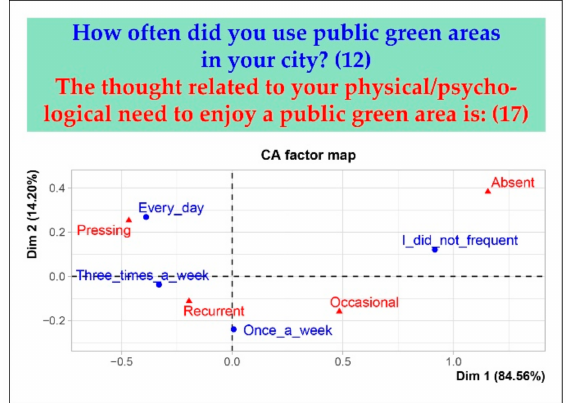
Figure 6. CA results for the relationship between the respondent use of public green areas and favorite elements before the social distancing period and the perception about them during social distancing (questions